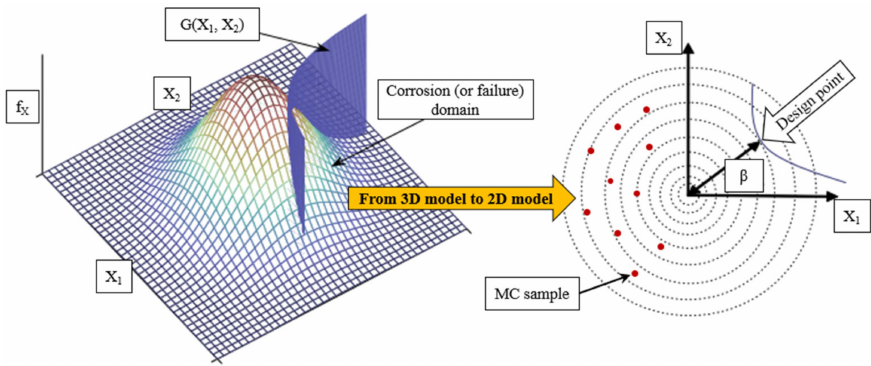
Figure 1. Illustration of FORM and MCS methods (adapted from